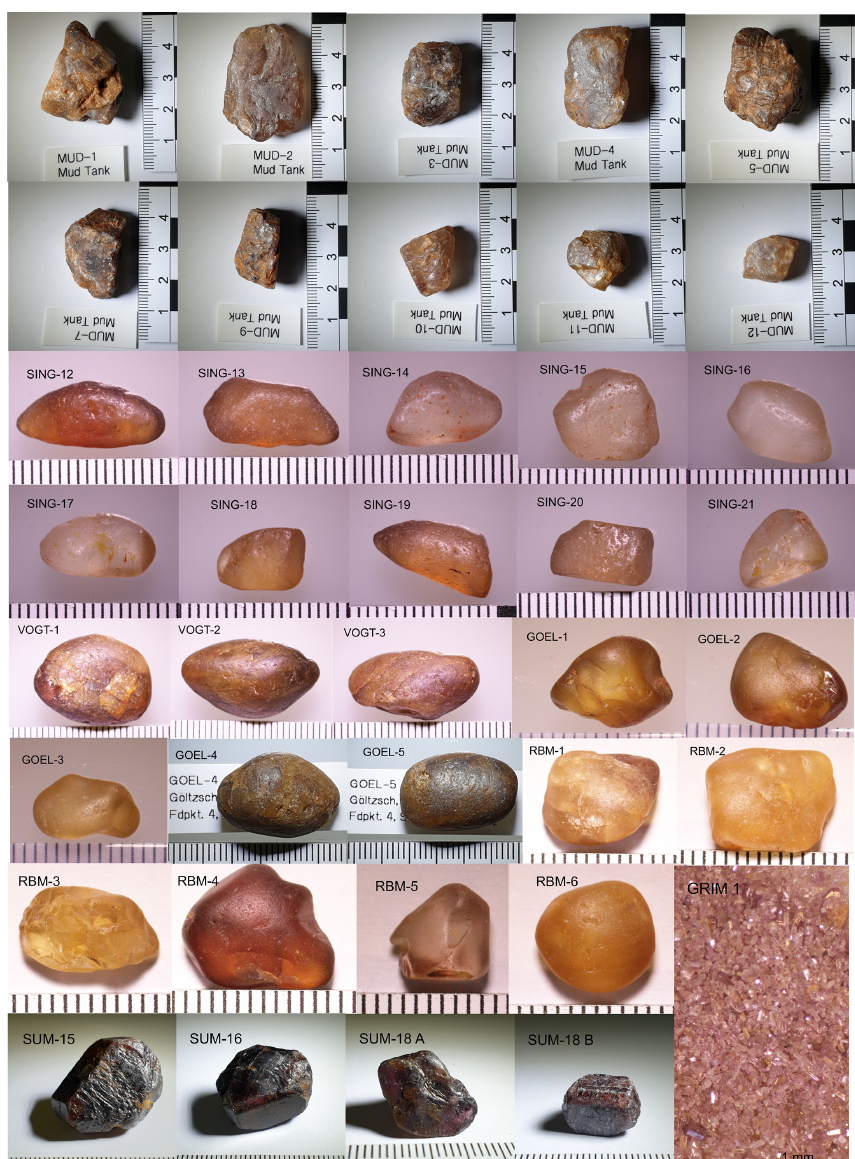
Figure 3. Photos of the zircons investigated. Scales are millimetres and centimetres. GRIM-1 is also exemplary for samples GRIM 19-1 and GRIM 19-2 (not shown). Crystals’ weights are provided in Table 1 (where